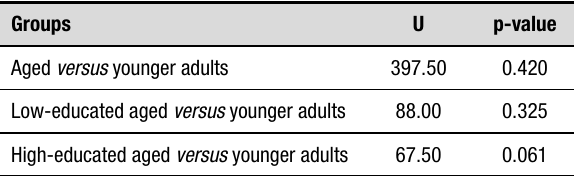
Table 1. Comparison of phonetic-phonological performance of younger and aged adults from the Brazilian capital, Federal District, using the Mann-Whitney